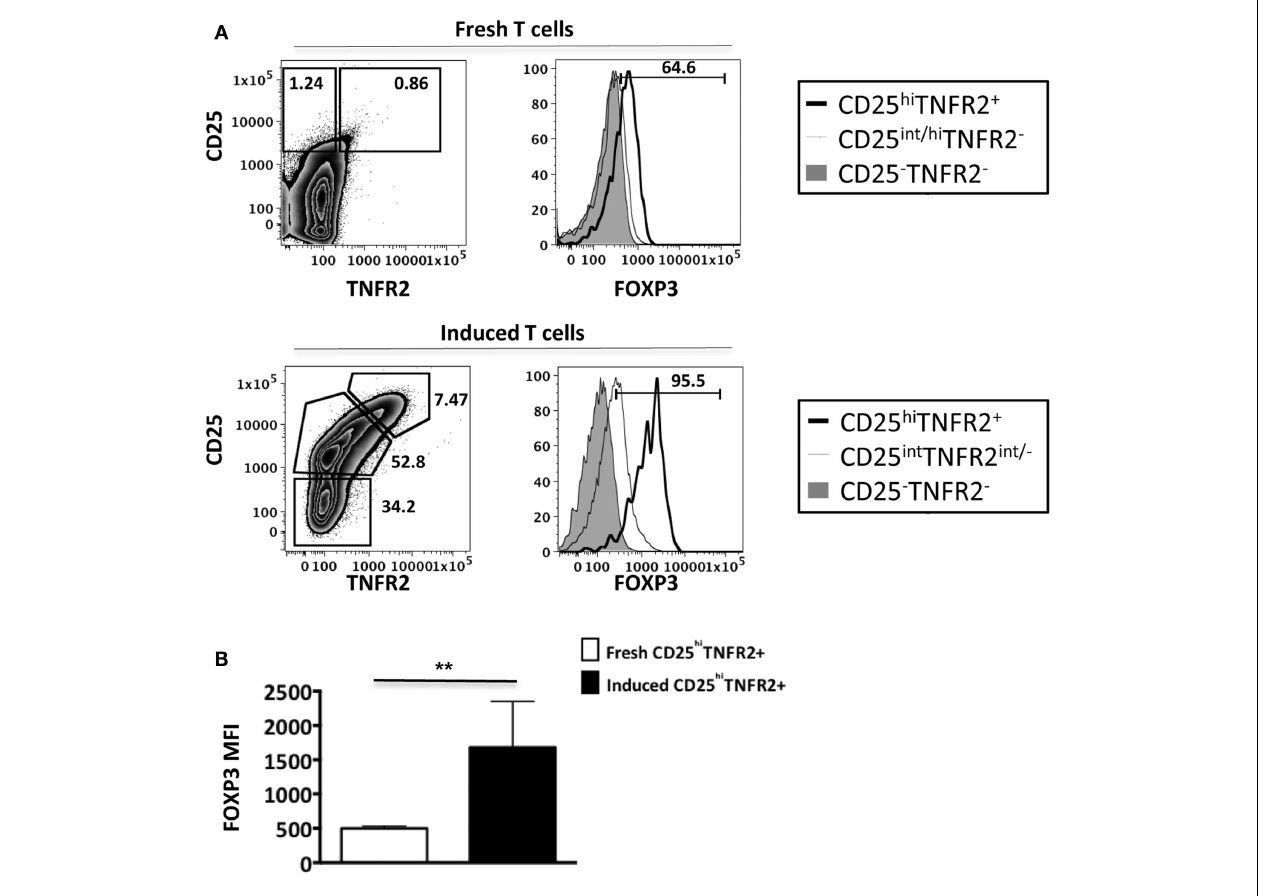
further compared between CD25 − TNFR2 − (tinted histogram), CD25 int TNFR2 int/ − (thin clear histogram), and CD25 hi TNFR2 + (thick clear histogram). (B) The FOXP3 expression levels were compared between ex vivo CD25 hi TNFR2 + and induced CD25 hi TNFR2 + T cells. Unpaired Student’s t -test was performed to compare FOXP3 levels and graphs represent mean ± SEM. **** p <